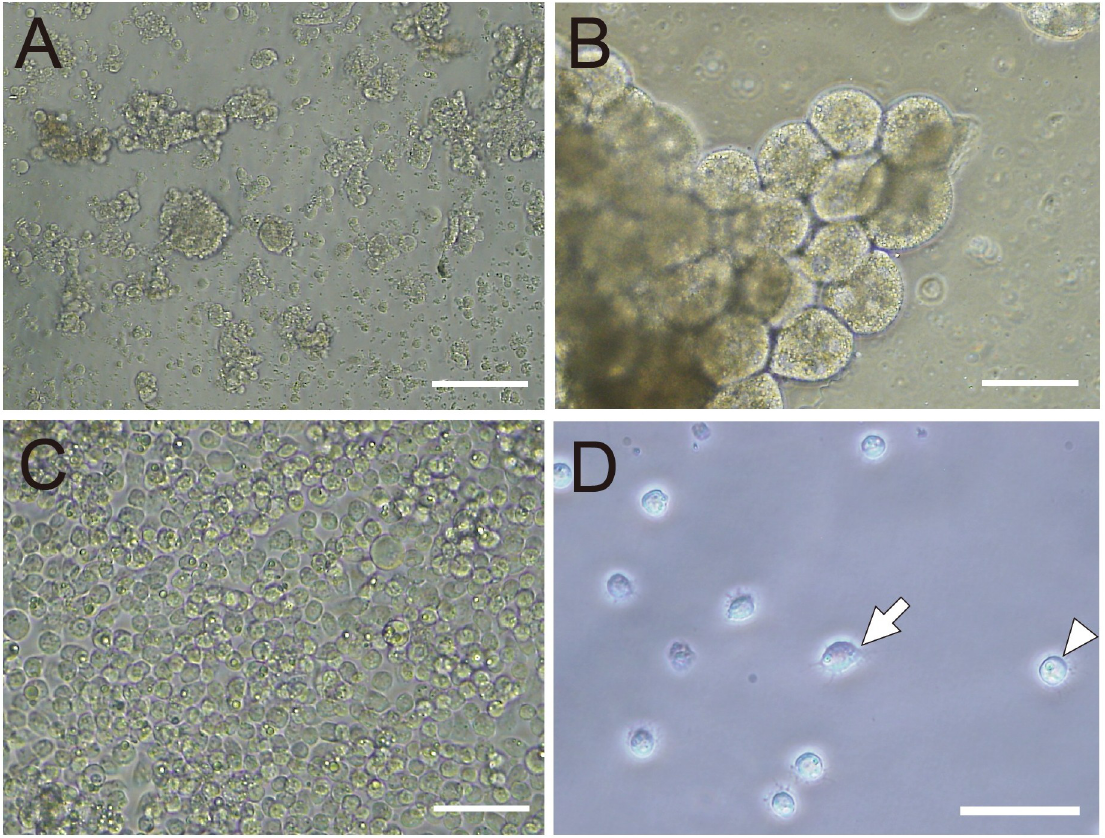
Fig 3. Morphology of honey bee cells prepared from each tissue. A. Embryonic cells derived from whole embryos. B . Pupal fat body cells were aggregated and irregular in shape and size. C . Hemolymph-derived cells were adherent and relatively uniform in shape and size. D . A magnified image of larval hemocytes. The arrow and arrowhead indicate a plasmatocyte and granulocyte, respectively. Bars indicate 100 μ m.